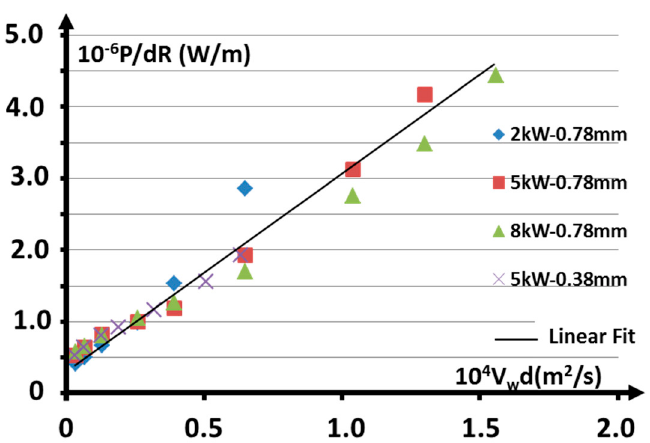
Figure 1. For different operating parameters (incident power P and spot diameters d), the plot of P/dR as a function of (V w d), corresponding best linear fit using Equation (4) [19] (from data published by Suder and Williams [26]).